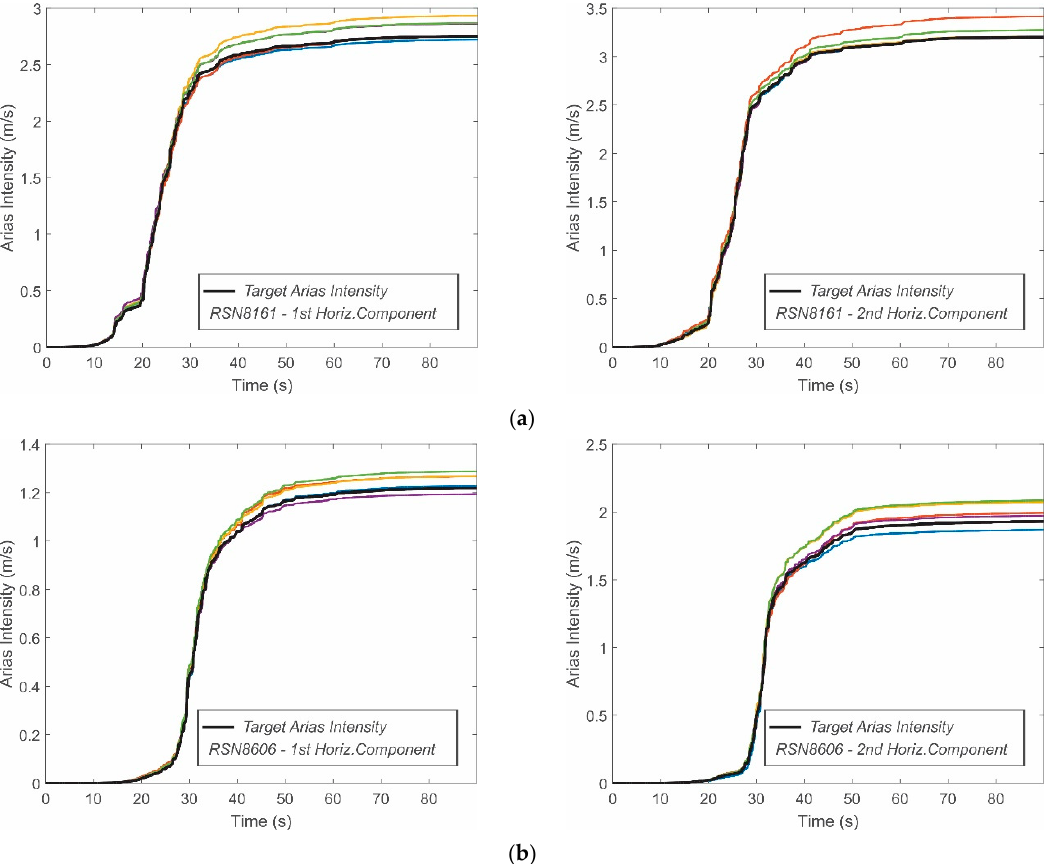
Figure 5. ( a ) Arias intensity of the real record from Table 1 for the station “El Centro Array #12” and the Arias intensities of five corresponding synthetic acceleration time histories shown in Figure 1a, for both horizontal ground motion components. ( b ) Arias intensity of the real record from Table 1 for the station “Westside Elementary School” and the Arias intensities of five corresponding synthetic acceleration time histories shown in Figure 1b, for both horizontal ground motion components.